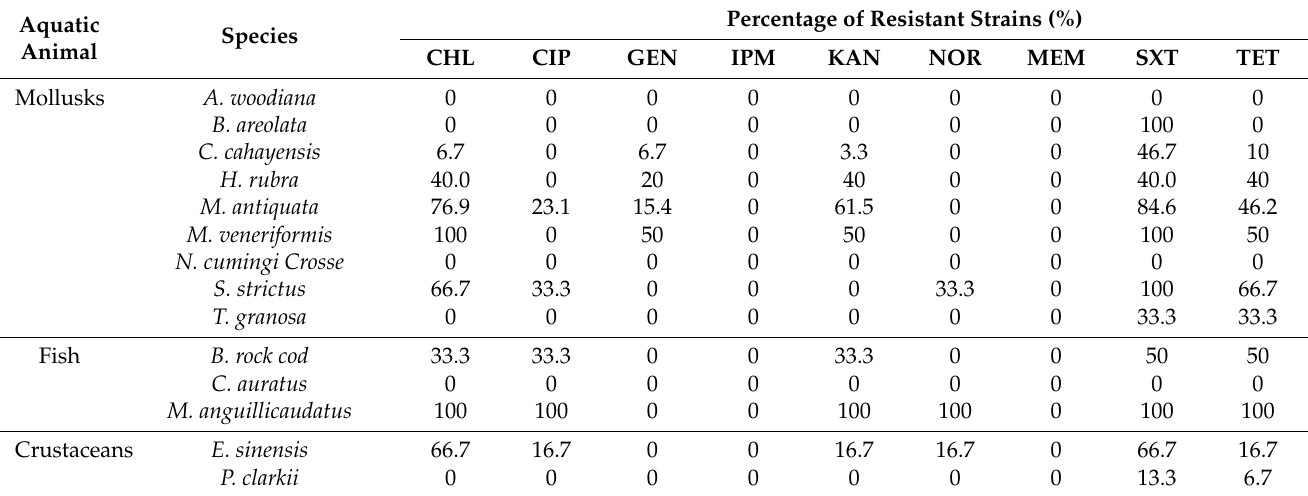
Table 4. The antibiotic resistance profiles of the 94 K. pneumoniae strains in the 14 species of aquatic